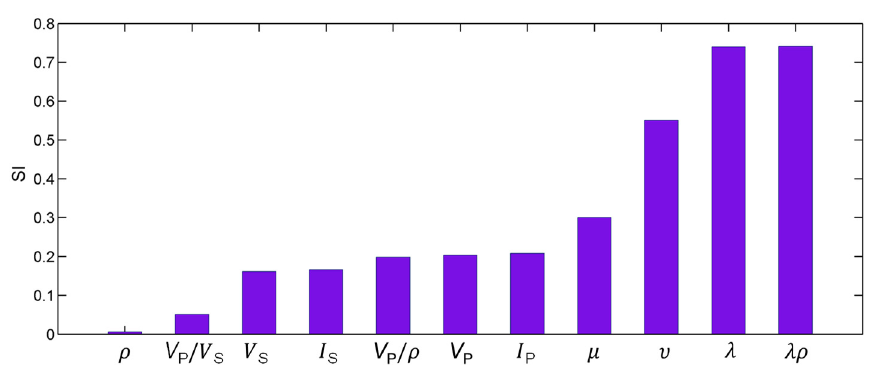
Figure 10. Sensitivity indices varying with the microcrack porosity.